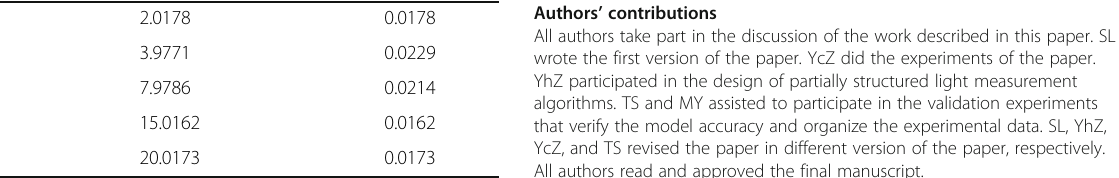
Table 2 Measurement results of gauge blocks (unit: mm) Block